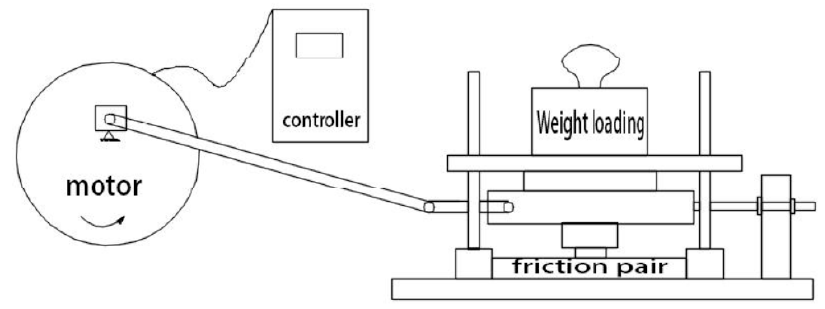
Figure 4. Linear reciprocating sliding friction and wear tester.